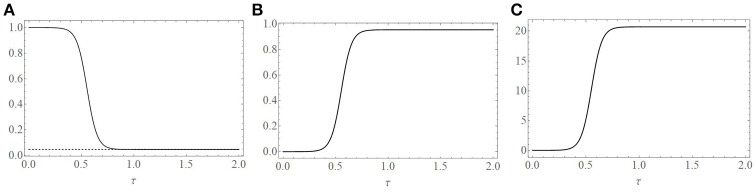
Plots of the uniformly valid additive composite solutions. (A) Uninfected cell population, xu(0)(τ), (B) infected cell population, yu(0)(τ), and (C) free virus population, vu(0)(τ). Populations are expressed as a percent of their initial population values. One dimensionless time unit (τ = 1) corresponds to 21 days. Parameters used to create the plots are given in the text and correspond to R0 = 21.7 and ε = 0.007.